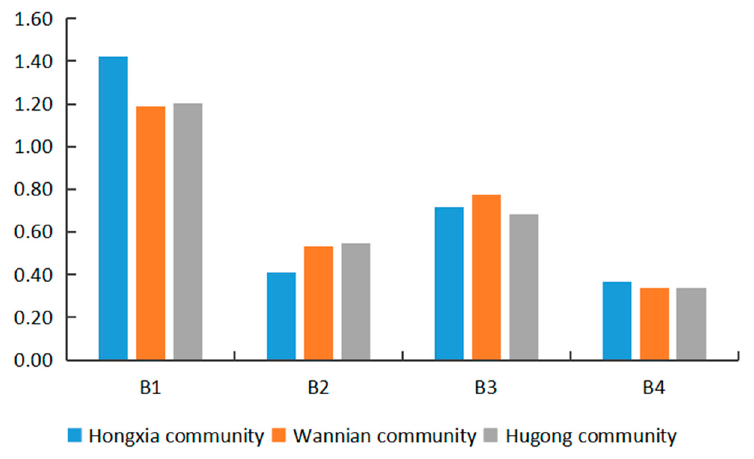
Figure 7. The resilience of three population communities in each dimension.